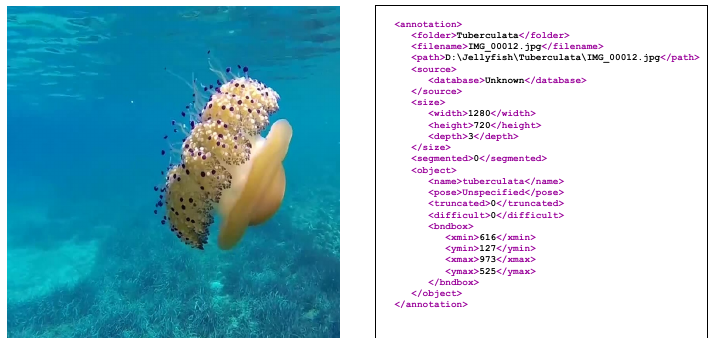
Figure 4. Left : Original image. Right : Corresponding ground truth “.xml” file, specifying the jellyfish location and